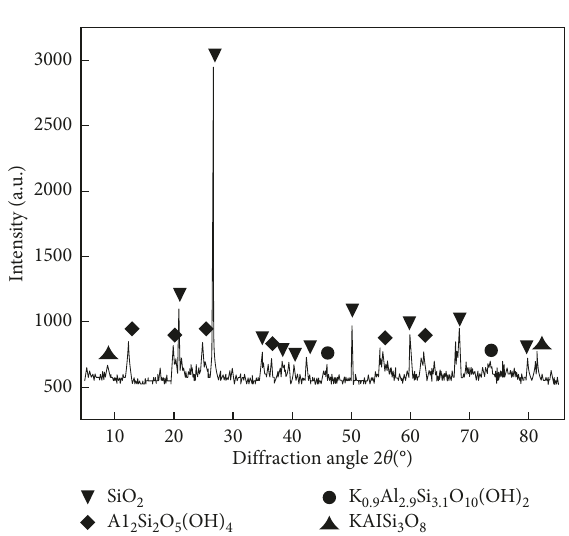
Figure 2: XRD spectrum of the